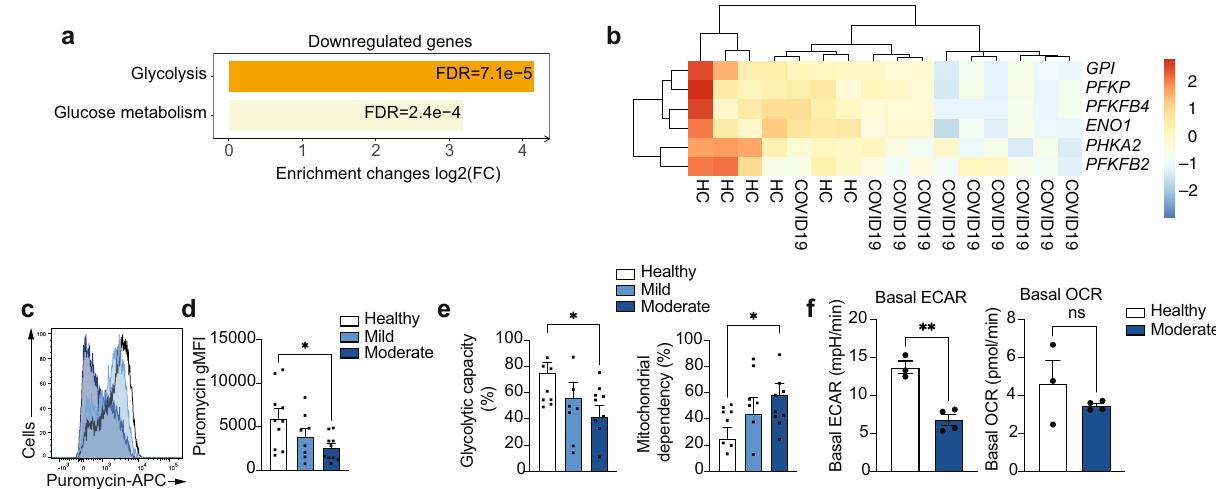
Fig. 3 | Altered expression of glycolysis-related genes in COVID-19 monocytes ex vivo. a Bar plots depict signi fi cantly enriched (FDR<0.05) pathways from Reactome for COVID-19 vs. healthy individual monocytes, using downregulated genesinCOVID-19vs.healthy( ≥ 1.5folddecrease,FDR<0.05).Thefoldenrichment is plotted on the x-axis as log 2 (FC) and the bars labelled with the adjusted p-value. b Heatmap of the signi fi cantly downregulated genes in COVID-19 vs. healthy monocytes that are members of the pathways in i . Gene expression values are scaled by row, with relatively high expression indicated in red and relatively low expression in blue. Both rows and columns are clustered using Euclidean distance andWard ’ smethod.Representativeexampleofexvivoexpressionofpuromycinin